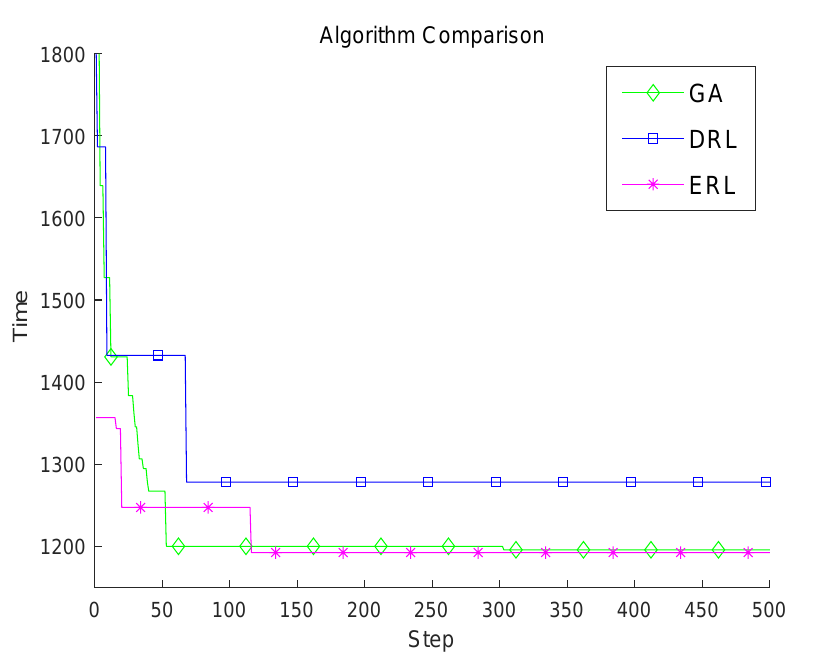
Figure 4. Comparison of the best results of different